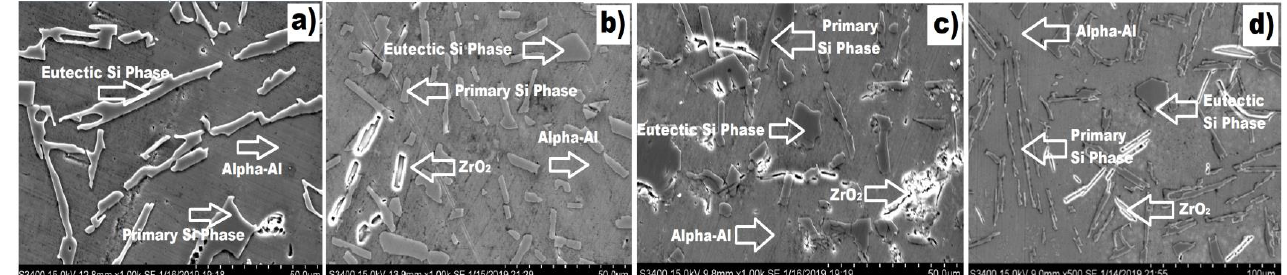
Figure 1. SEM image of Si-Al alloy matrix reinforced with ( a ) 0% ( b ) 5%, ( c ) 10% ( d ) 15 wt.% of ZrO 2 particulates of mean diameter 25 µm.